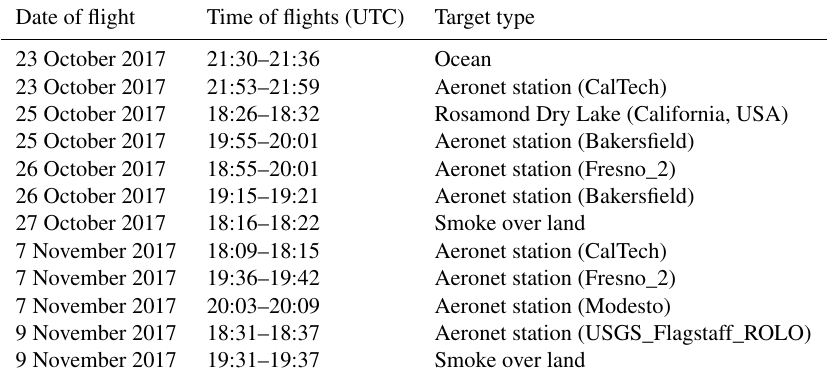
Table 2. Table of flights analyzed from the ACEPOL campaign which flew over the ocean, land, forest fire smoke, and AERONET sites.